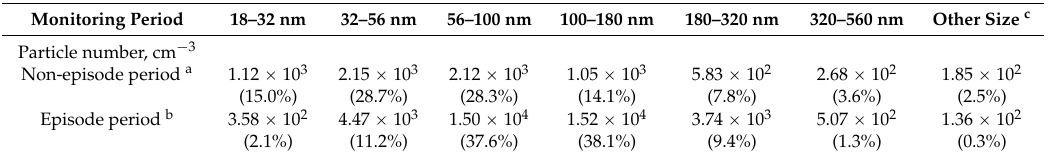
Table 2. Particle number concentrations in seven selected fractions during the corn straw open-field burning period and the same period on the reference